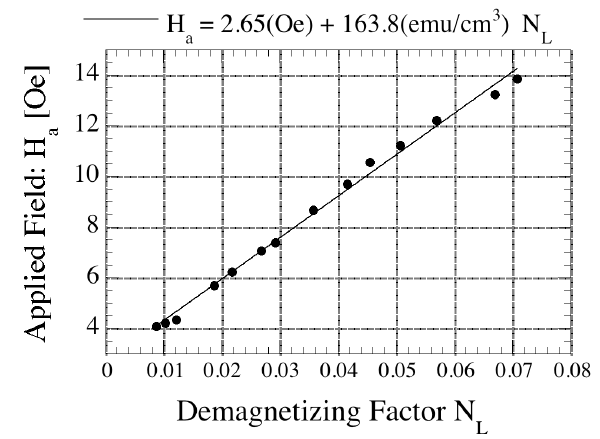
Figure 4. Applied magnetic DC bias field needed to reach minimal resonant frequency vs. demagnetizing factor for magnetoelastic sensors of varying lengths. Reprinted with permission from